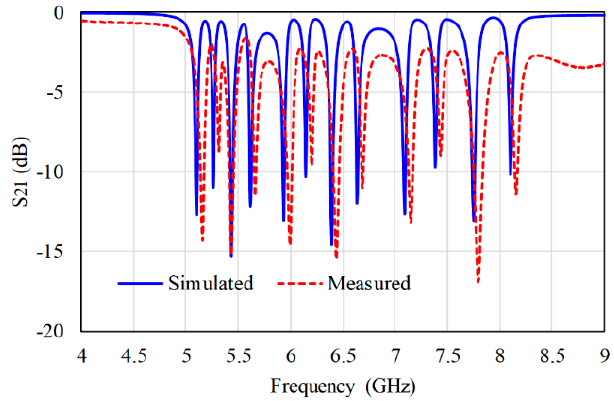
Figure 10. Fabricated codes: ( a ) 111111111111, ( b ) 101010101010, and ( c ) 010101010101.